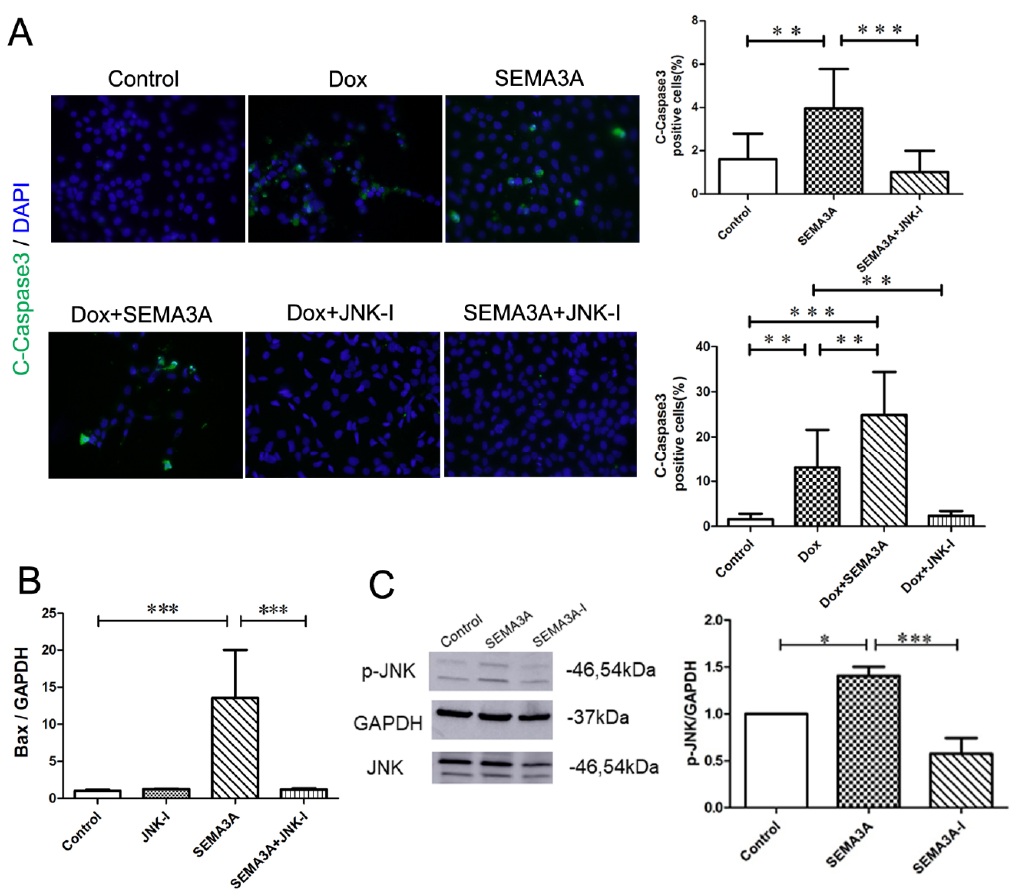
Figure 6. JNK-inhibitor blocked SEMA3A-induced podocyte apoptosis. ( A ) Immunofluorescence